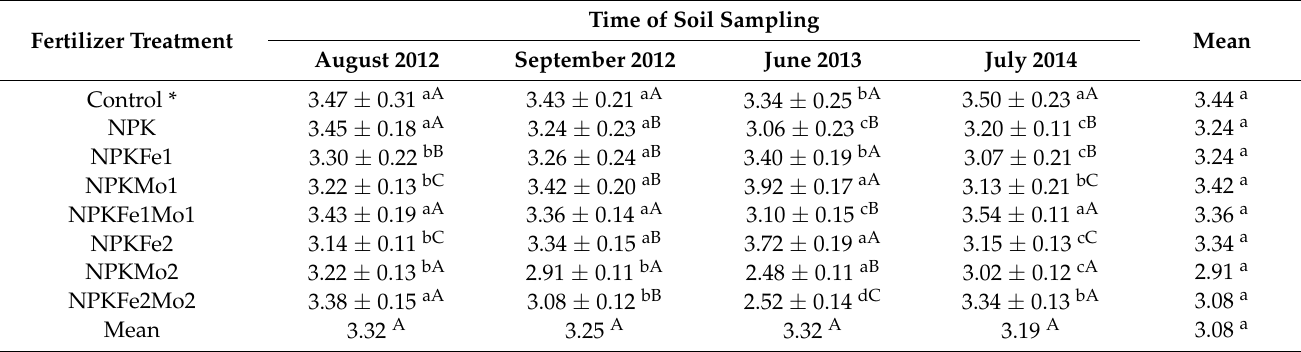
Figure 6. ( a ) The correlations between dehydrogenases activity and alkaline phosphatase activity, ( b ) alkaline phosphatase activity and acid phosphatase activity.